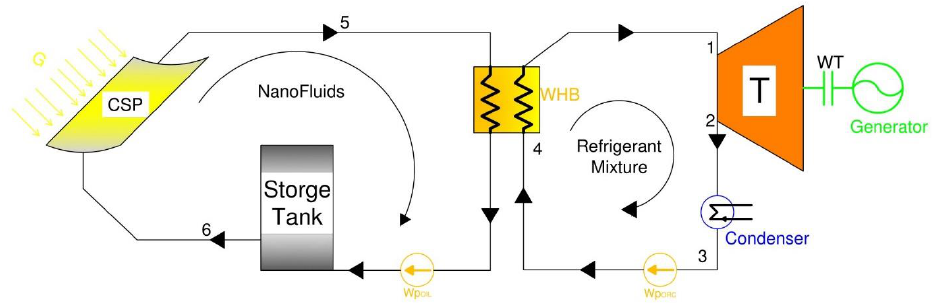
Figure 1. Flow diagram of the proposed system.